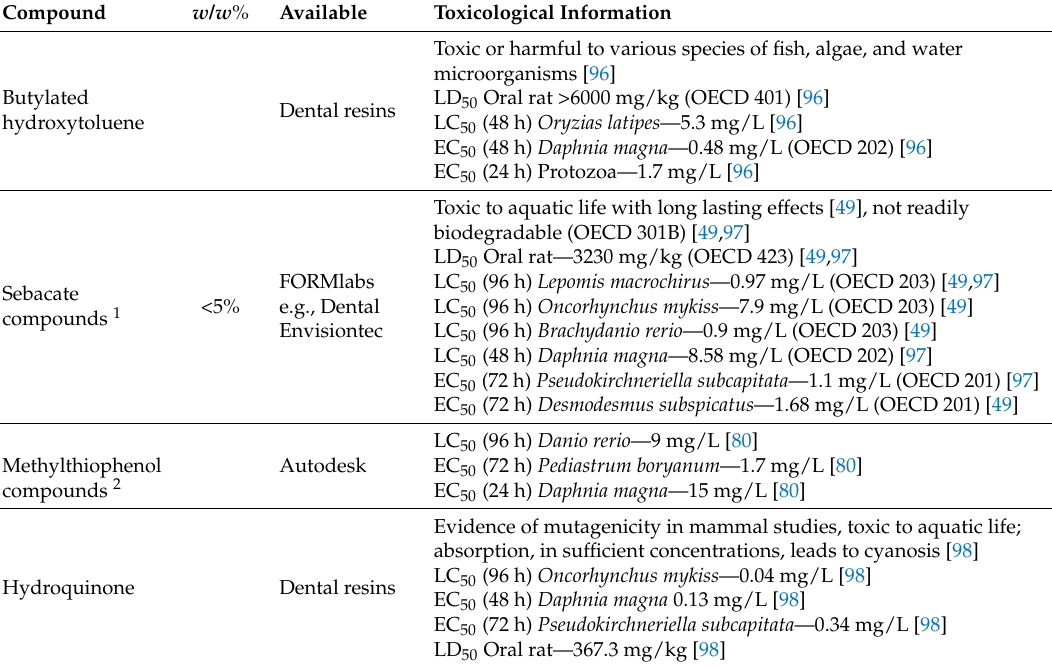
Table 3. Summary of toxicity data available for auxiliary compounds used in stereolithography resins.